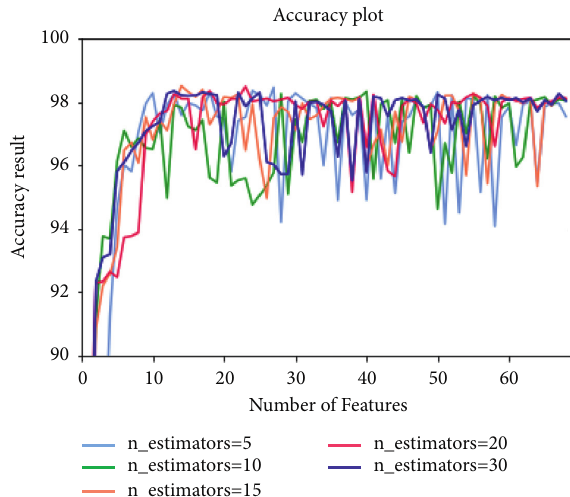
Figure 8: Cross-validated accuracy result on CICIDS2017-Wed2 dataset.